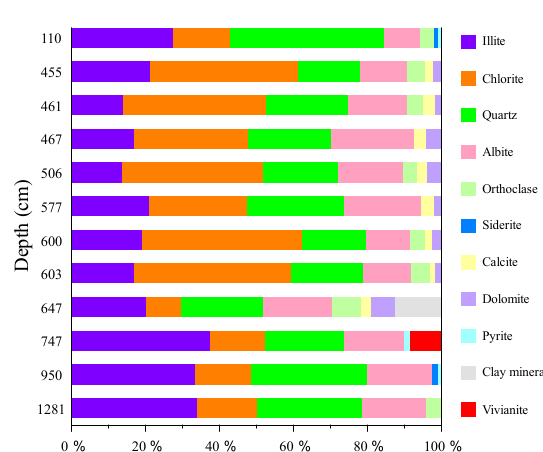
Figure 6. XRD-derived depth profiles depicting the relative min- eralogy of the grey to green mineral aggregates isolated from core 973-4. Some of the clay minerals from the sample at 647cm depth remain